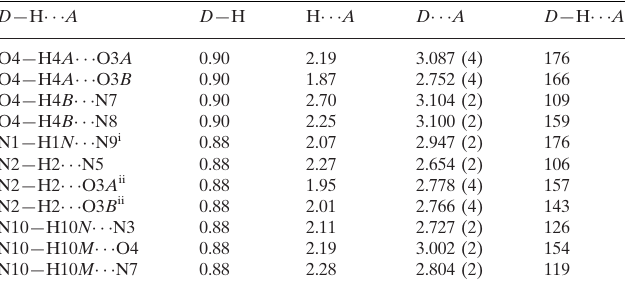
Hydrogen-bond geometry (A˚ , (cid:3)